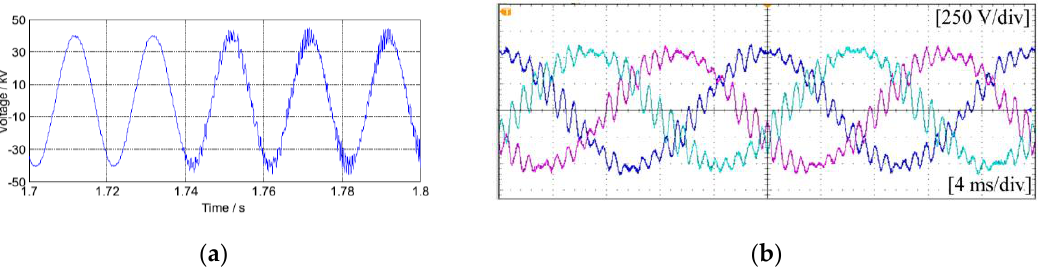
Figure 7. Measured overhead catenary system (OCS) voltage and experiment waveform with harmonic instabilities (HI). ( a ) Traction power substation (TPSS) voltage in electric railway power systems (ERPS) [64]. ( b ) Phase-to-phase unstable voltage [83].